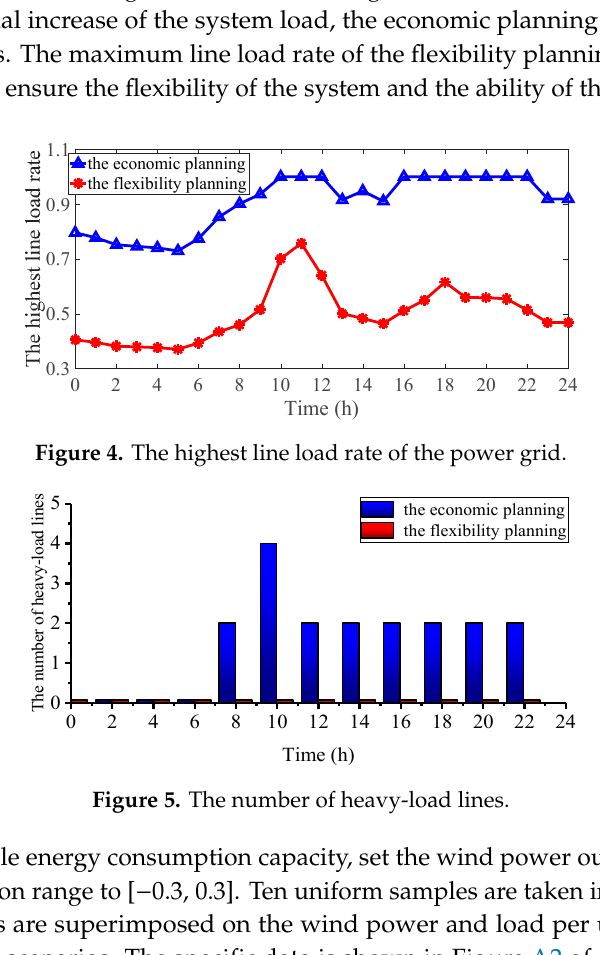
($ / year) total C Figure 3. Flexibility–Economy pareto frontier. Table 1. Comparison of planning scheme results in typical scenarios.